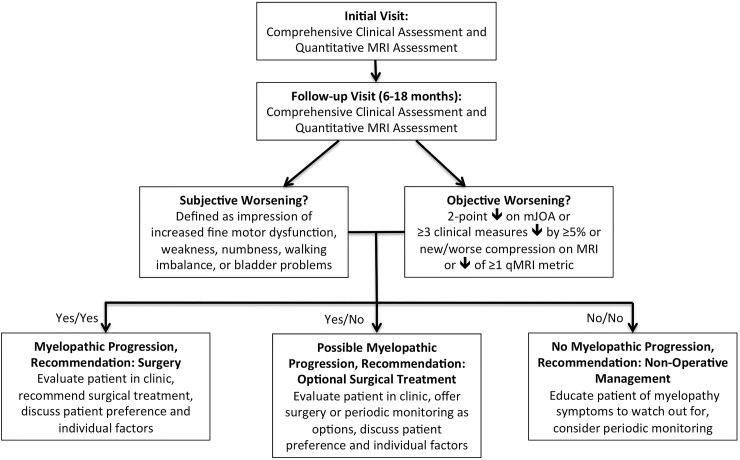
Decision-making algorithm for degenerative cervical myelopathy patients initially managed non-operatively.The decision-making algorithm requires clinical and quantitative MRI data collection at 2 time-points, and takes into account the patient’s subjective impression of worsening and objective measures of progression, including mJOA, a battery of clinical assessments, anatomical MRI, or quantitative MRI.